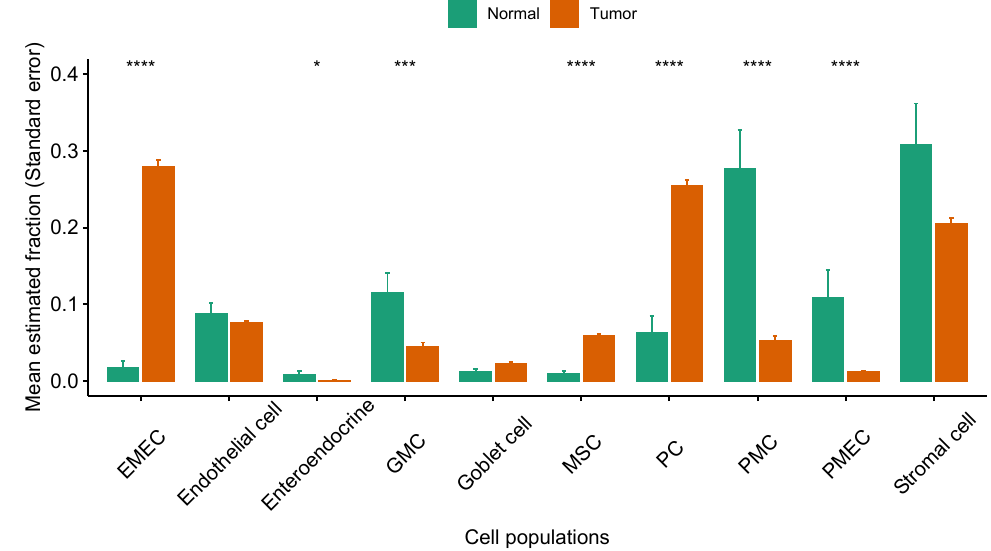
Figure 8. Comparison of the relative abundance of non-immune cell populations between normal and tumor samples in the TCGA-STAD cohort, * p < 0.05; *** p < 0.001; **** p <